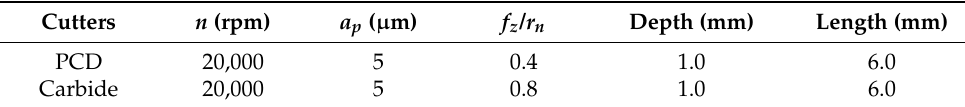
Table 5. Parameters of deep-and-narrow micromilled